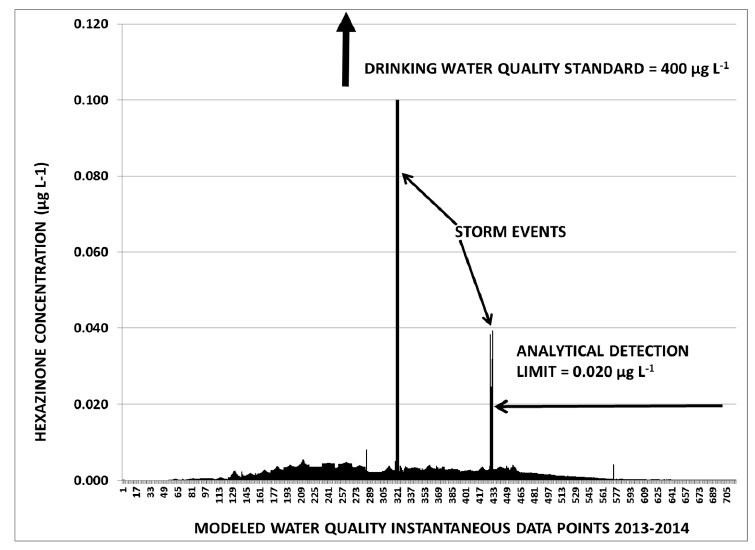
Figure 11. Year 2—modeled instantaneous concentrations of hexazinone in the Rangitaiki River at the Rangitaiki flow gauge. Rangitaiki flow gauge.